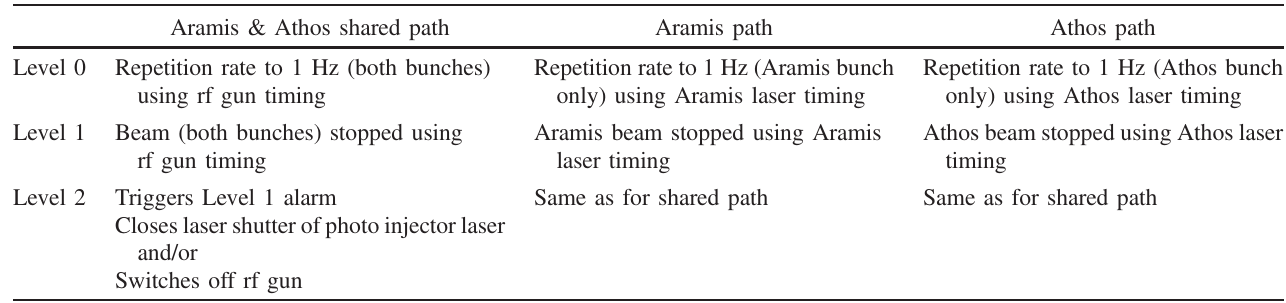
TABLE I. Alarm levels of the Machine Protection System.